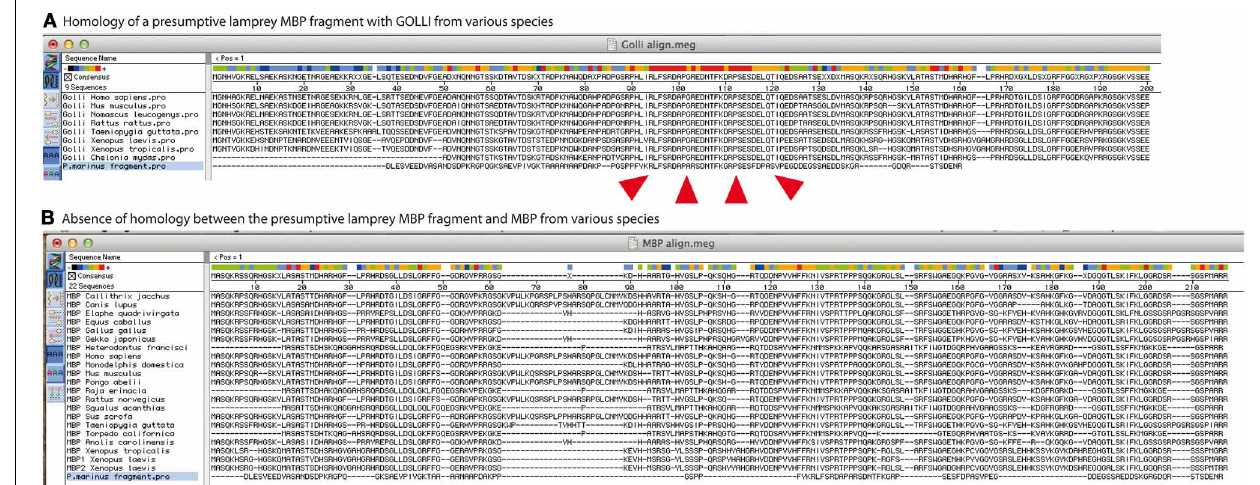
FIGURE 1 | A possible ortholog of gene-of-the-oligodendrocyte-lineage (GOLLI) protein, not myelin basic protein (MBP), was identified in the sea lamprey genome. (A) GOLLI and (B) MBP protein sequences of the indicated species were retrieved from the NCBI database and aligned with the presumptive MBP fragment identified in the sea lamprey genome by Smith et al. (2013). The software Megalign from